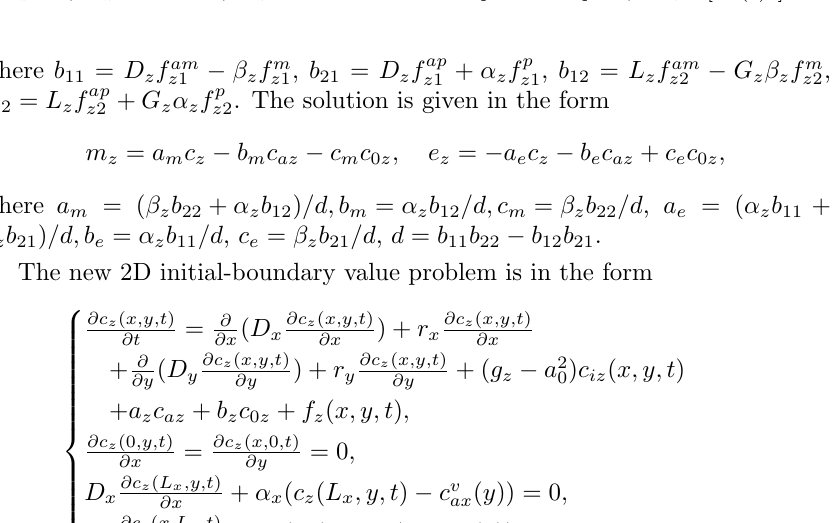
Figure 5. Two layers solutions for L z = 3 ,D 1 z = 10 e − 03 ,D 2 z = 10 e − 04